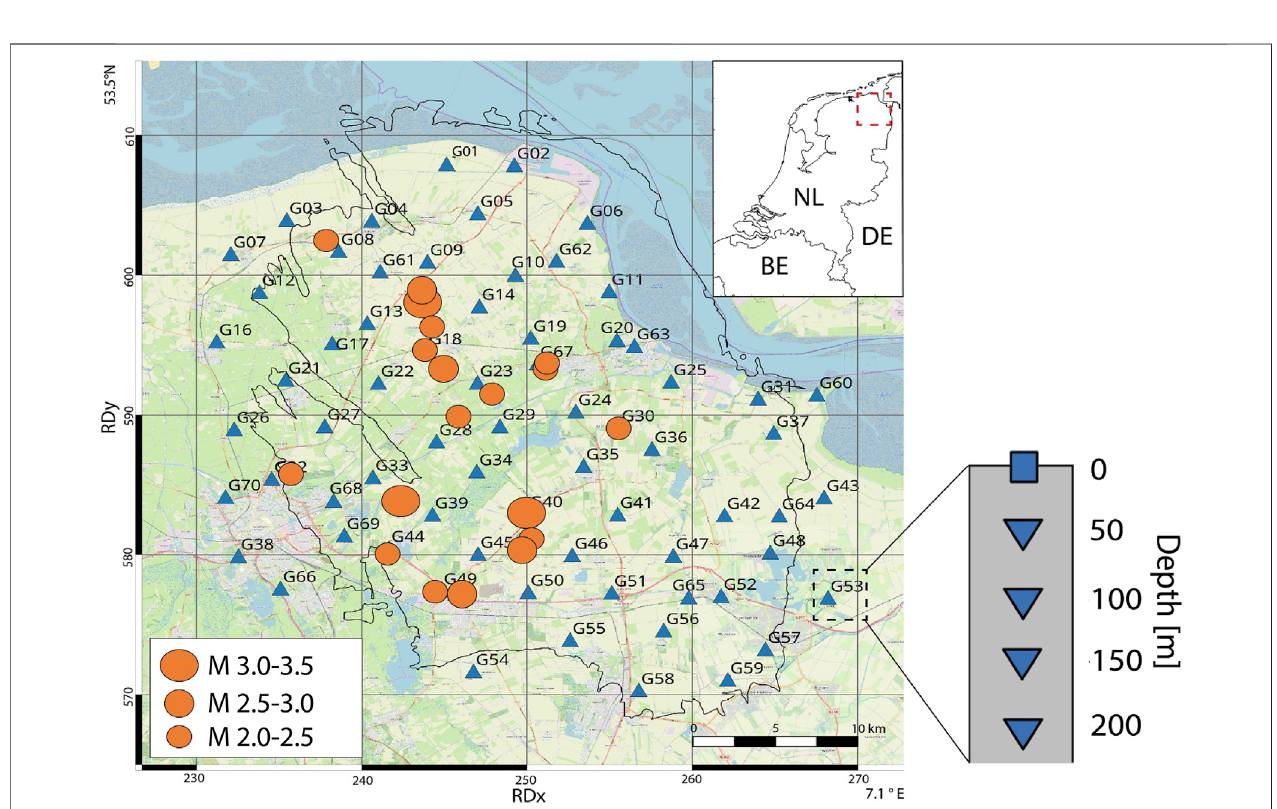
FIGURE 2 | Map view of the Groningen borehole network in the northeast of the Netherlands. The triangles represent the surface location of each borehole site in the network. Each borehole contains an accelerometer at the surface and four 4.5 Hz geophones at depth with a 50 m depth spacing. The orange circles represent the local earthquakes with magnitude 2 or higher, recorded in the G-network between 05 – 2015 and 05 – 2019. Coordinates are shown within the Dutch National Triangulation Grid (Rijksdriehoekstelsel or RD) and lat/lon coordinates in the corners for international referencing. Background map: OpenStreetMap contributors, CC-BY-SA,